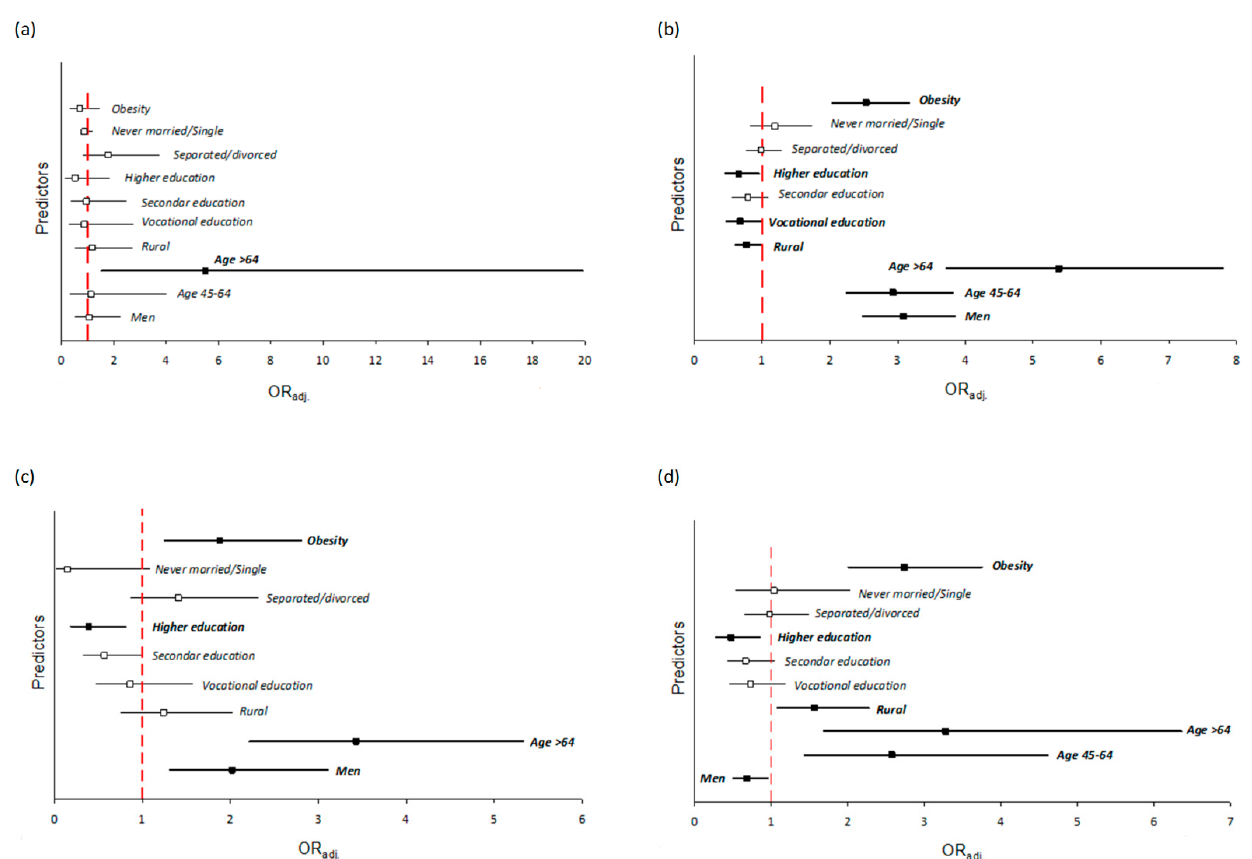
Figure 1. The odds ratios (with 95% CI) of the factors associated with occurrence of stroke ( a ), hypertension ( b ), CHD ( c ), and diabetes ( d ) among the study population (the odds ratios were adjusted to sex and/or age, as indicated previously in Table 2).